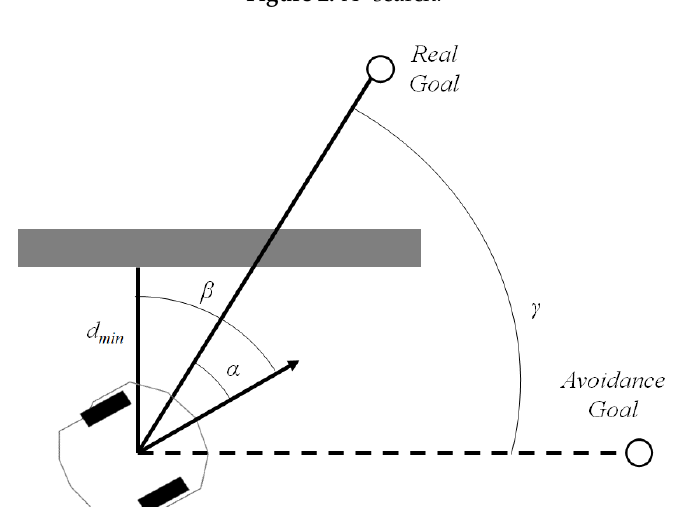
Figure 2. A* search.